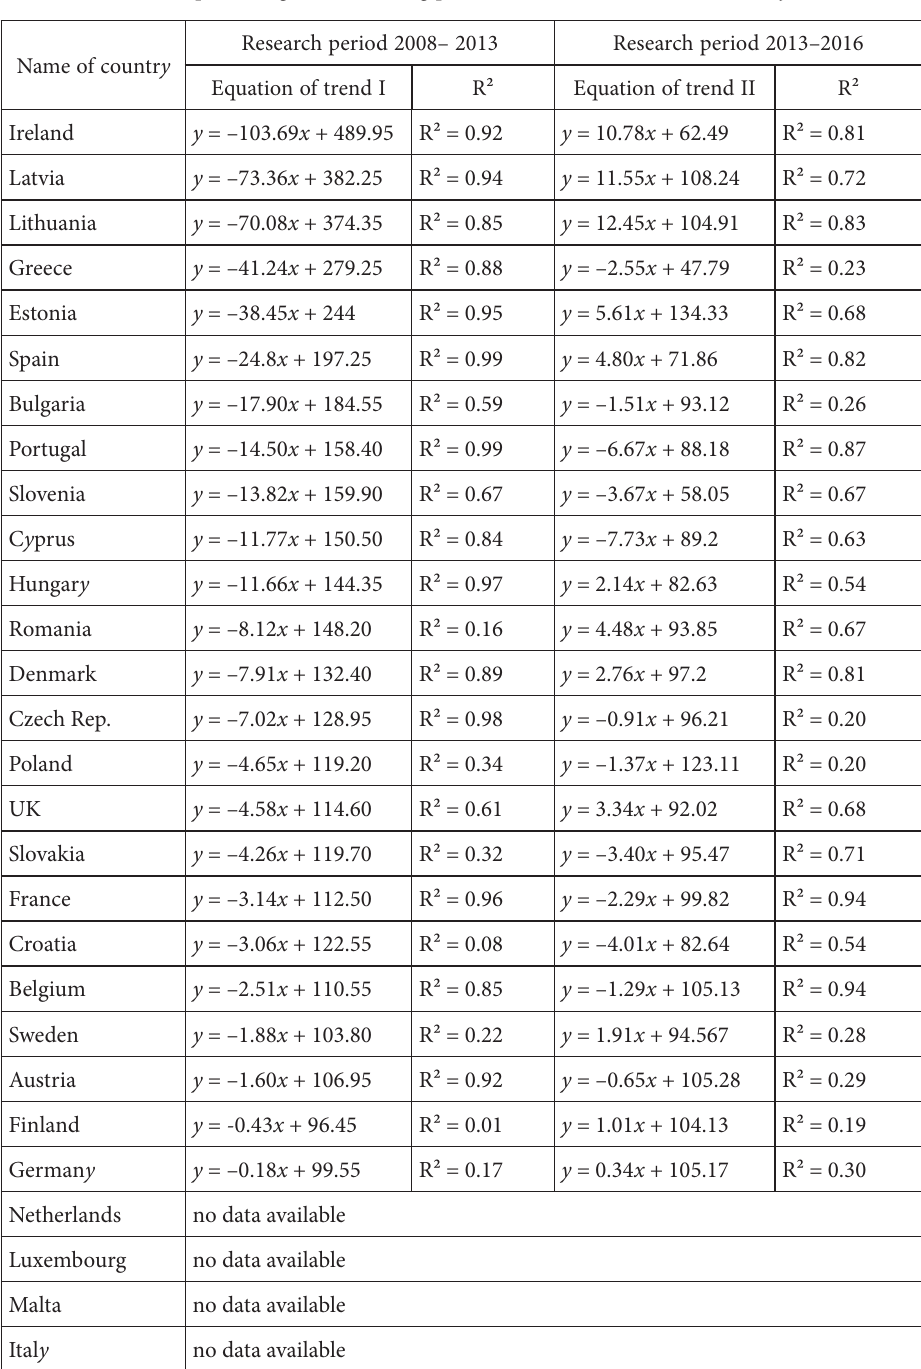
Table 4. Calculations pertaining to the building production (source: author’s own stud y